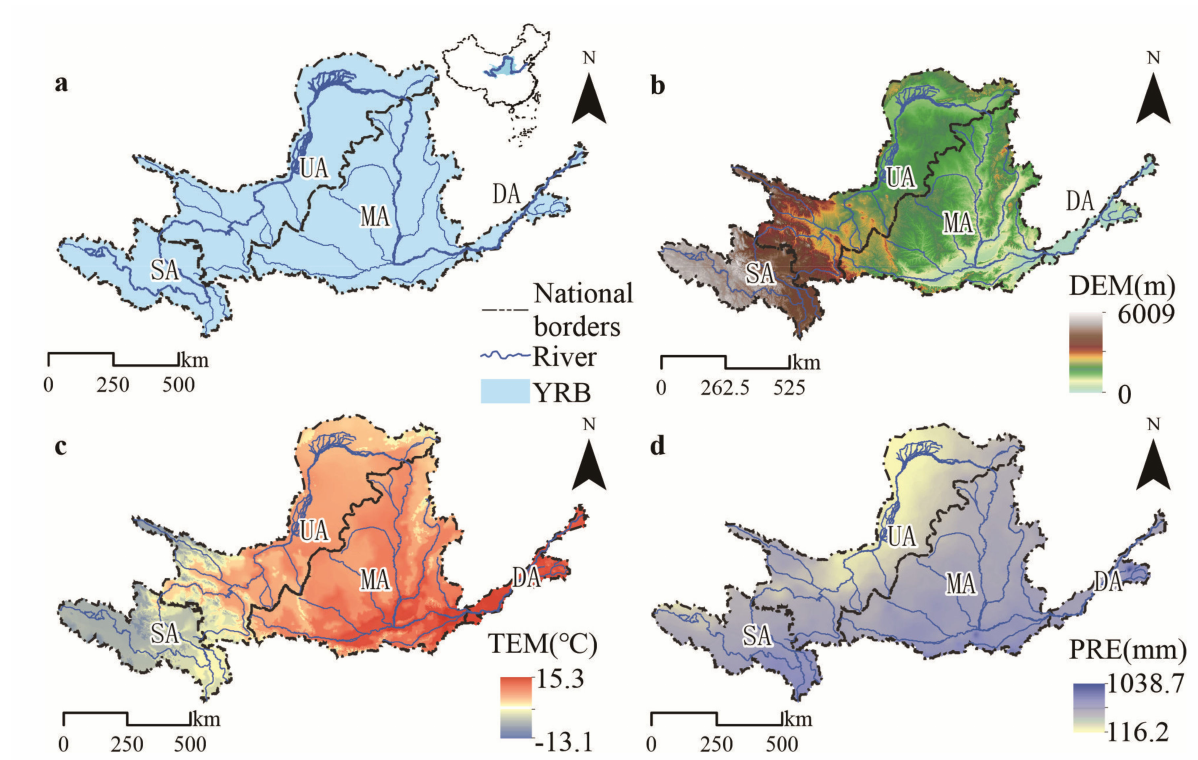
Figure 1. Location and overview of the YRB. ( a ) Basin area. ( b ) Digital elevation model (DEM). ( c ) The annual average temperature. ( d ) The annual average precipitation. SA, UA, MA, and DA represent the Source Area, Upstream Area, Midstream Area, and Downstream Areas of YRB,